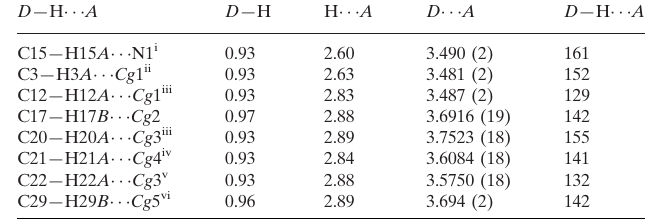
Hydrogen-bond geometry (A˚ , (cid:2)